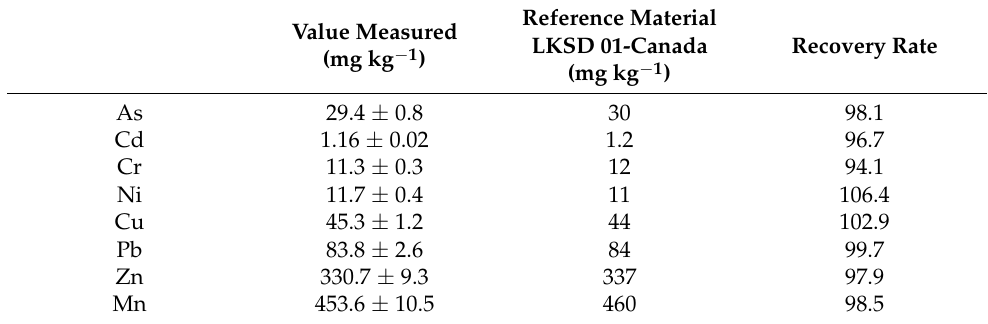
Table 1. Recovery rates percentage for elements in the standard reference material (LKSD